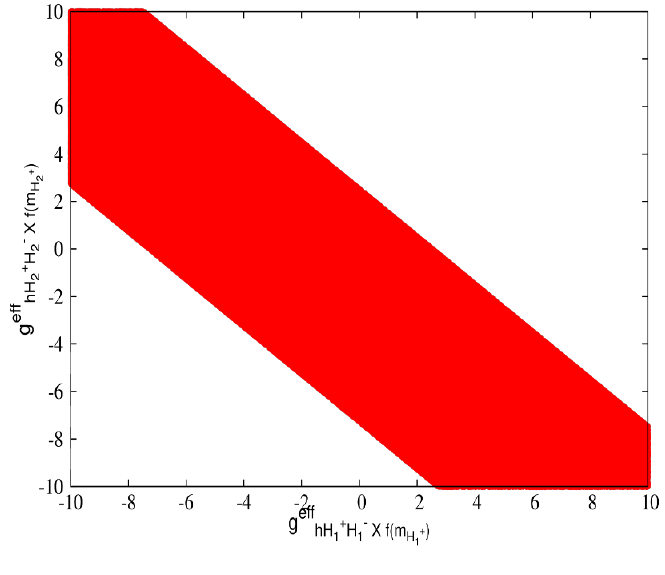
(cid:2) f ( m ) and g e(cid:11) (cid:2) f ( m ) H (cid:6) 1 H (cid:6) 2 hH + 1 H (cid:0) 1 hH + 2 H (cid:0) 2